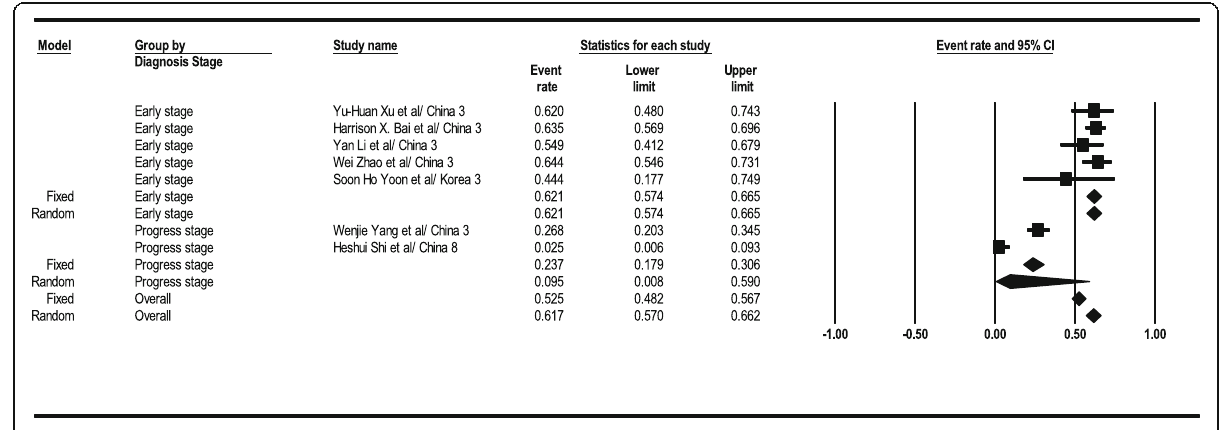
Fig. 4 Results of GGO in CT scan of patients